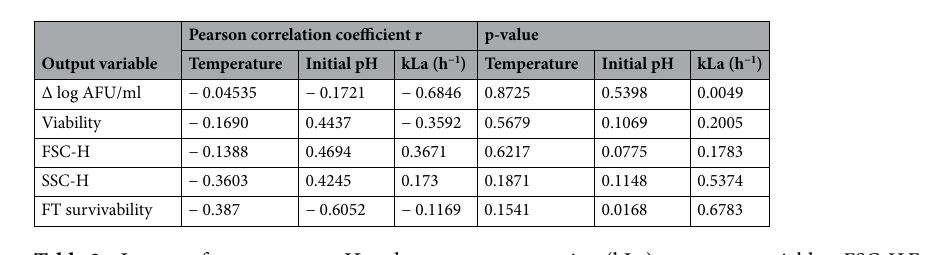
Table 2. Impact of temperature, pH and oxygen concentration (kLa) on output variables. FSC-H Forward scatter height, SSC-H Side scatter height.